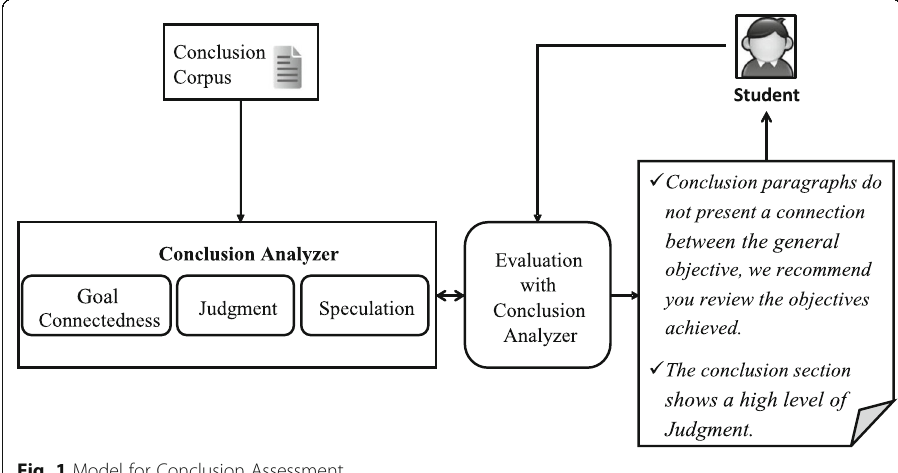
Fig. 1 Model for Conclusion